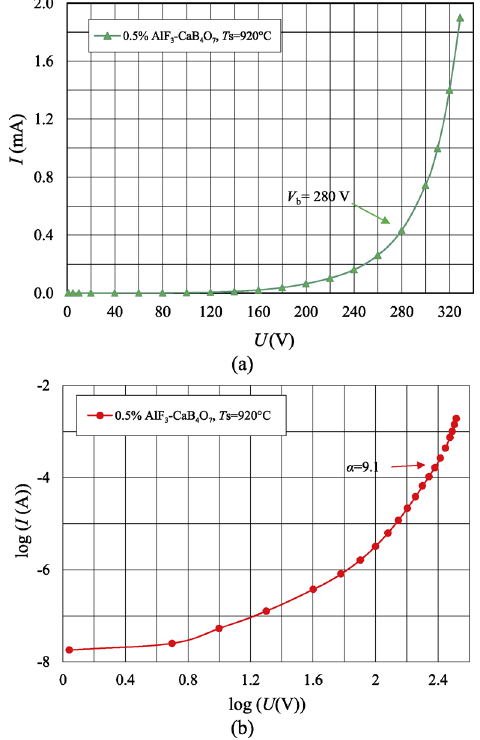
Fig. 9 Current–voltage characteristics of the multilayer varistor with 0.5 wt% of AlF 3 –CaB 4 O 7 , sintered at 920 ℃ :